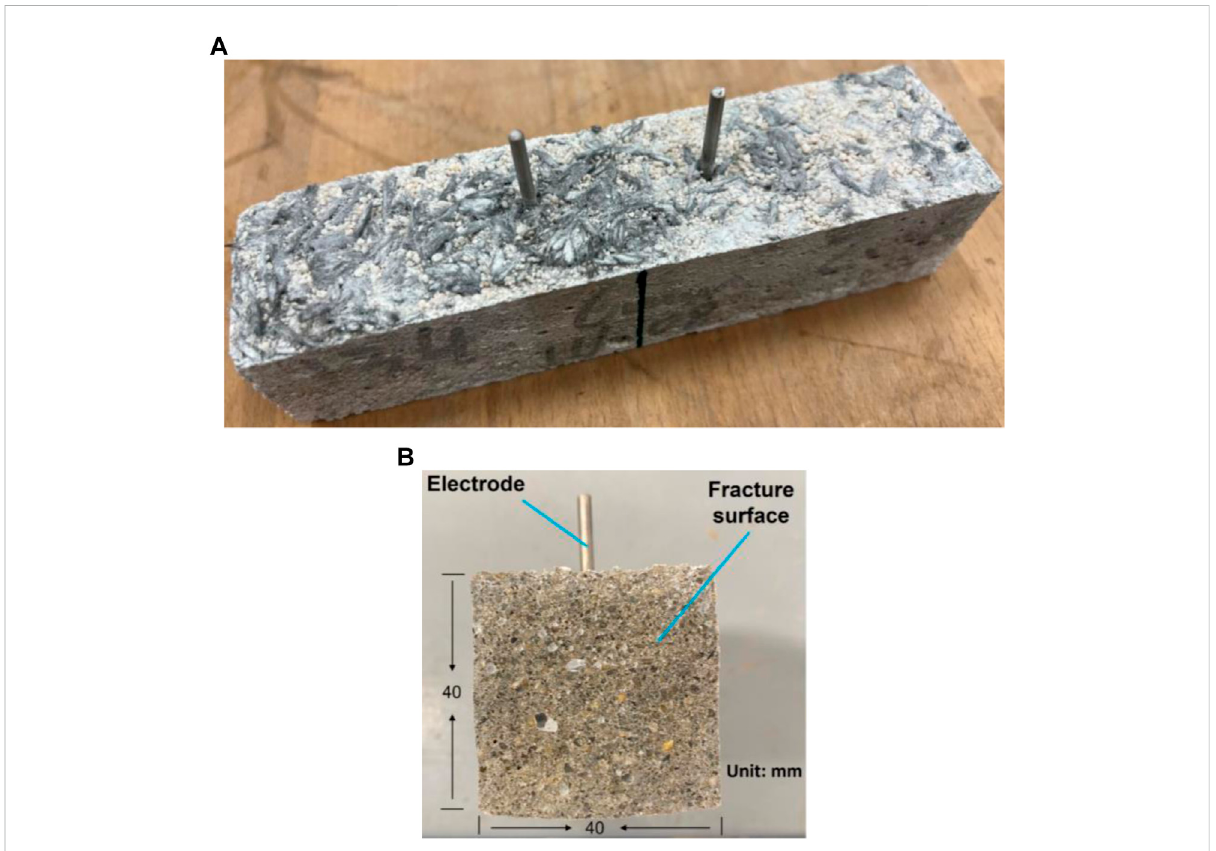
FIGURE 3 Physical appearances of smart cement-based composites (A) appearance of the composite with the highest fi bre content 2.4 vol% showing segregation and clumping of fi bres which can be visually con fi rmed (B) fracture surface of composite with a relatively low fi bre content 0.2 vol% showing no fi bres were visible to the naked